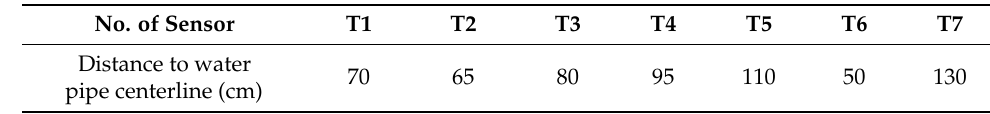
Figure 3. Locations of the temperature sensors. Table 1. Locations of the sensors.